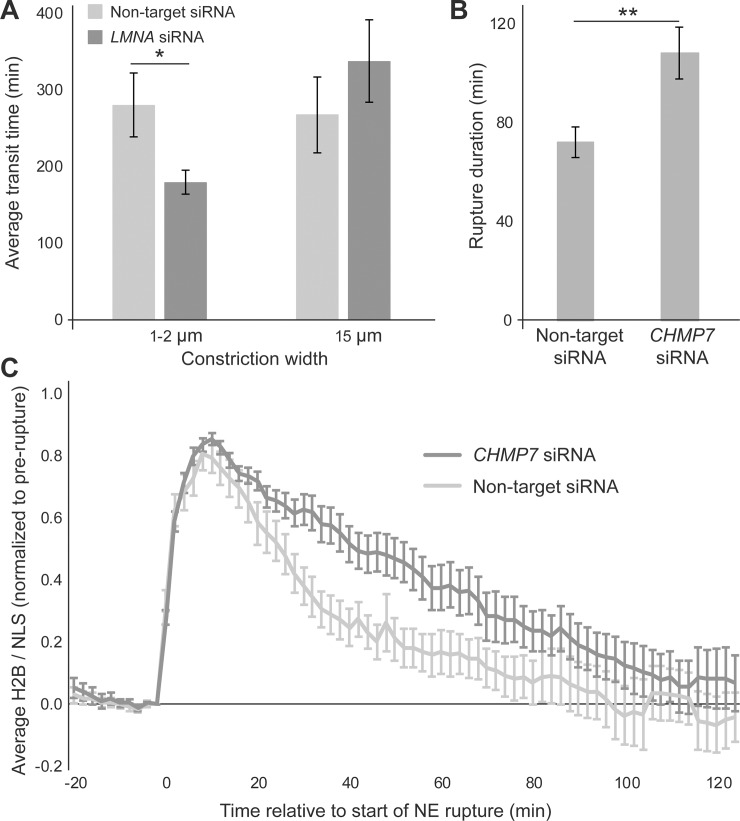
Application of automated image analysis program.(A) A549 cells depleted for lamin A/C (n = 40 cells across 4 microfluidic device sections) pass faster through small constrictions than non-target controls (n = 26 cells across 4 device sections). Transit times through larger openings were not statistically different (*, p < 0.05 as calculated by t-test; n = 21, 14, respectively). (B) HT-1080 cells depleted for CHMP7 (n = 65 cells across 3 device sections) took longer to repair their NE and restore nucleo-cytoplasmic compartmentalization than non-target controls (**, p < 0.01 as calculated by Mann-Whitney t-test; n = 48 cells across 3 device sections). (C) Dynamics of NE rupture and repair visualized by the ratio of nuclear H2B-tdTomato/NLS-GFP fluorescence for the CHMP7-depleted and non-target control cells. The H2B/NLS signal is expressed relative to its value at t = 0, i.e., immediately prior to rupture, and normalized to reach a peak value of 1 for each nucleus. CHMP7-depletion results in slower return to baseline, indicating delay in NE repair. Error bars represent mean ± s.e.m.